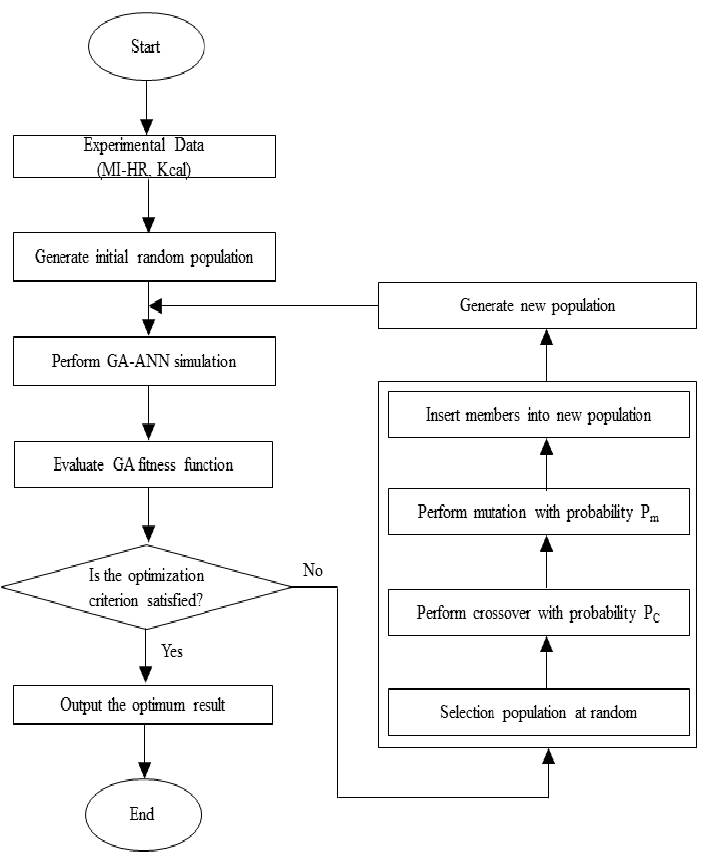
Figure 3. Optimization using artificial neural networks–genetic algorithms (ANN-GA).